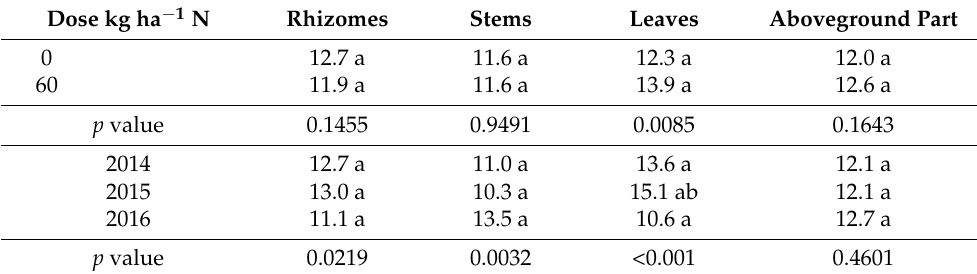
Dose kg ha − 1 N Rhizomes Stems Leaves